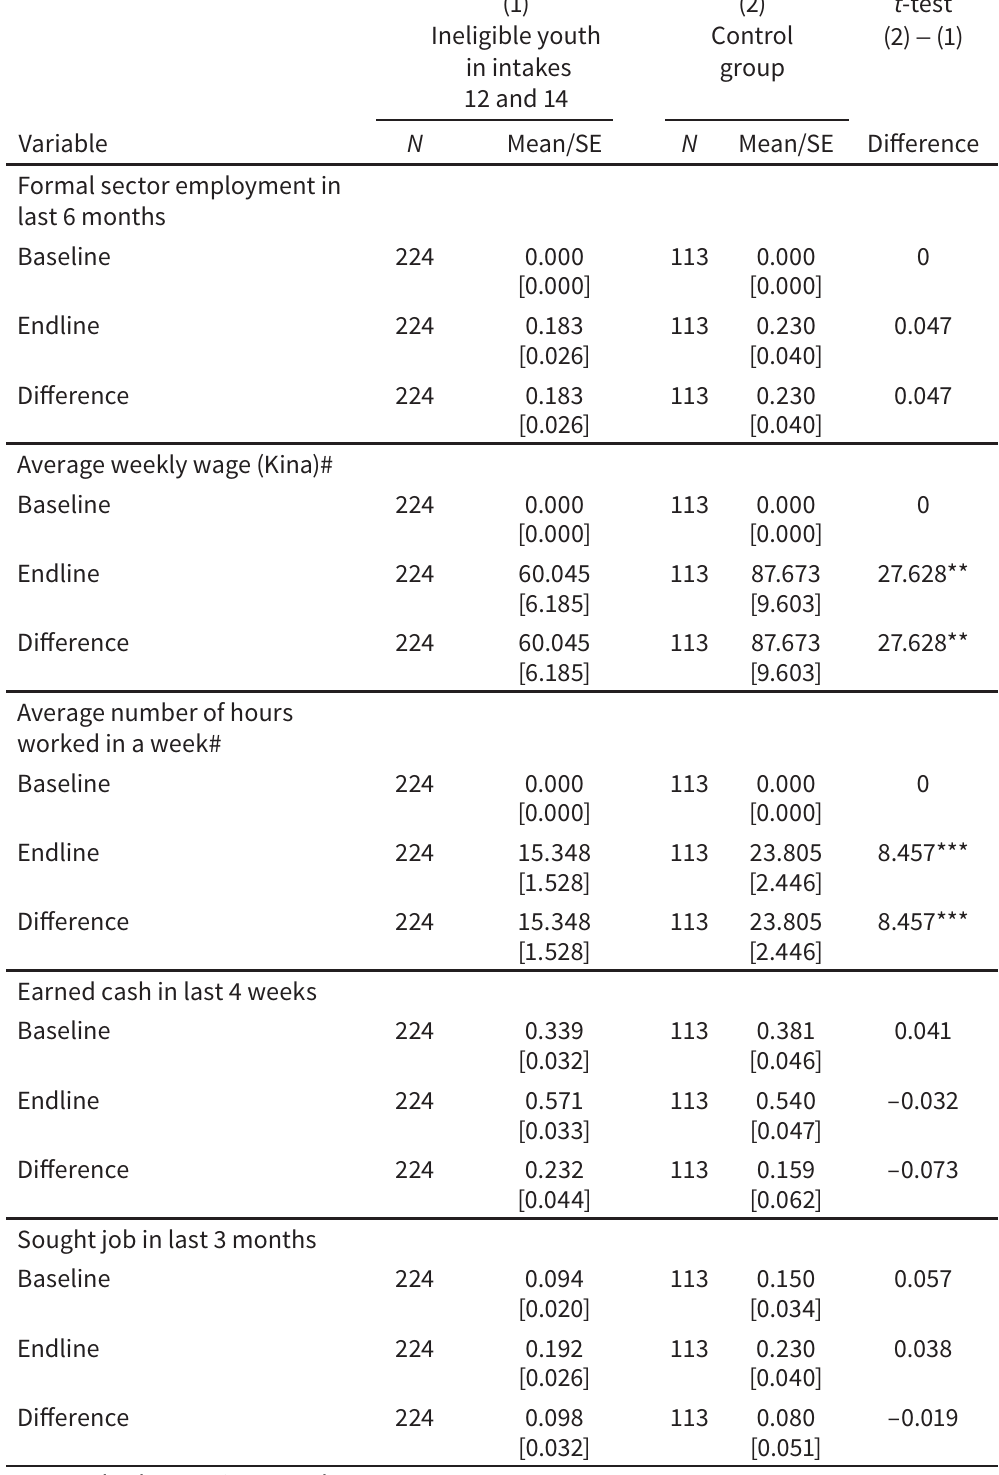
Table A4 Differences in outcomes between youth in the control group and youth who were ineligible in intakes 12 and